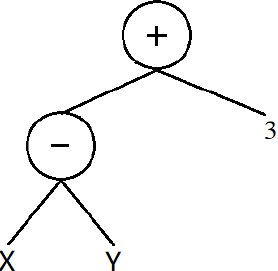
Figure 5. An example of individual